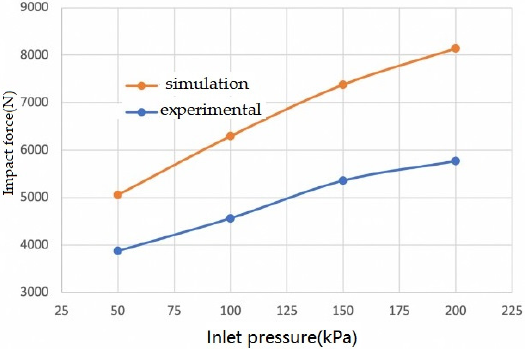
Figure 17. Comparison of the impact forces of stone particle impact coatings.